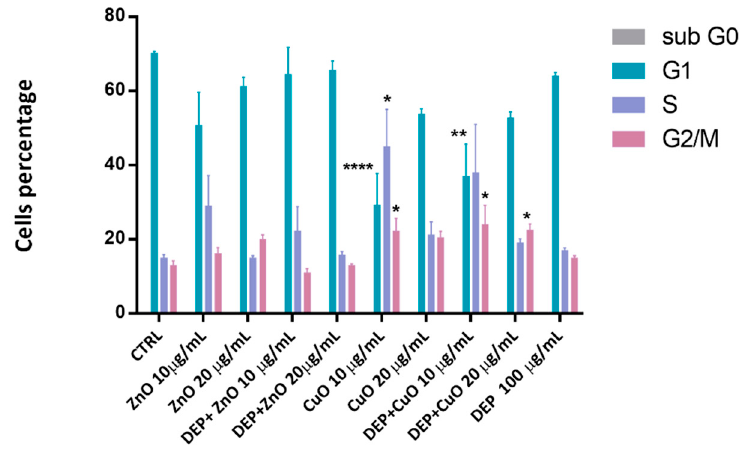
Figure 2. Cell cycle investigation. Cell percentage in each phase of the cycle after 24 h exposure to particles and mixtures (ZnO and CuO at 10 and 20 µ g/mL). Statistical analysis was performed using one-way ANOVA with Dunnett’s multiple comparisons tests. ** p < 0.01, * p < 0.05 and **** p < 0.0001 vs. control.